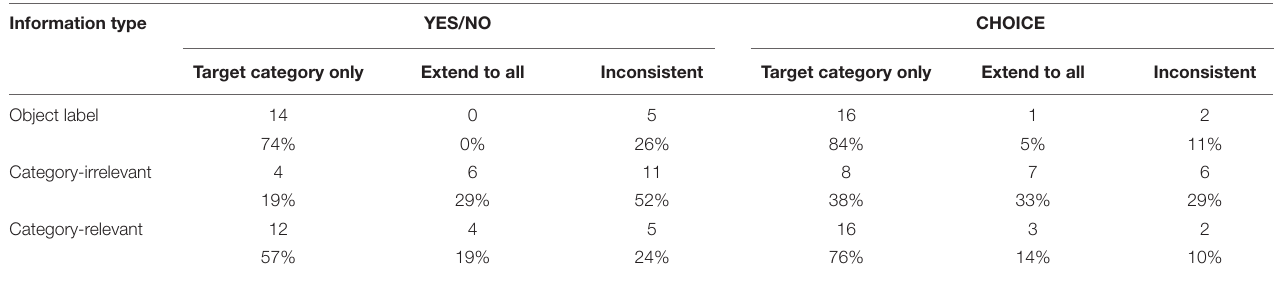
TABLE 2 | Extension Patterns by Information Type: the number and percentage of participants. Information